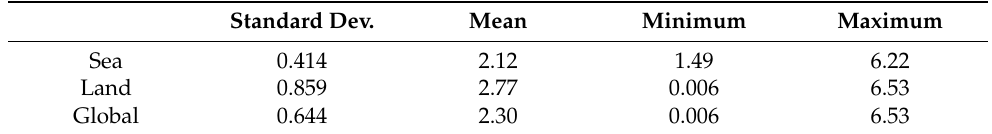
Table 2. Statistics of surface HCHO concentration for sea surface, land surface and combined (unit: μ g/m 3 ).